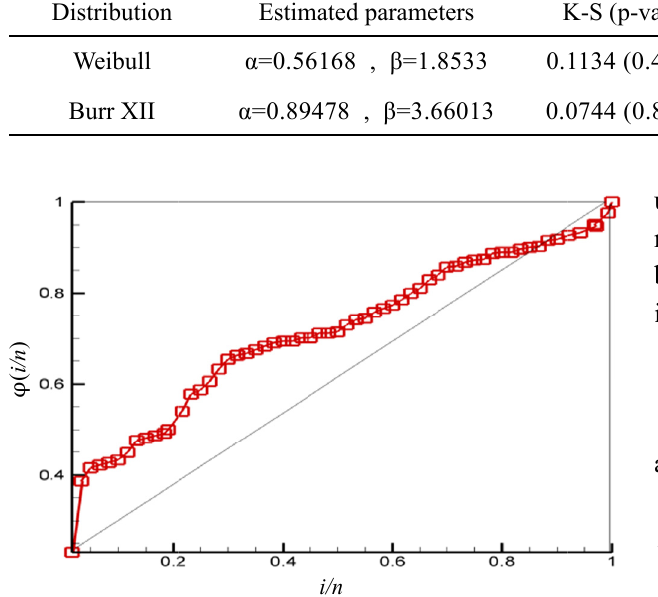
i/n Fig. 5. The scaled TTT transform of degree of splashing. Figure 5 The scaled TTT traansform of degre ee of splashing